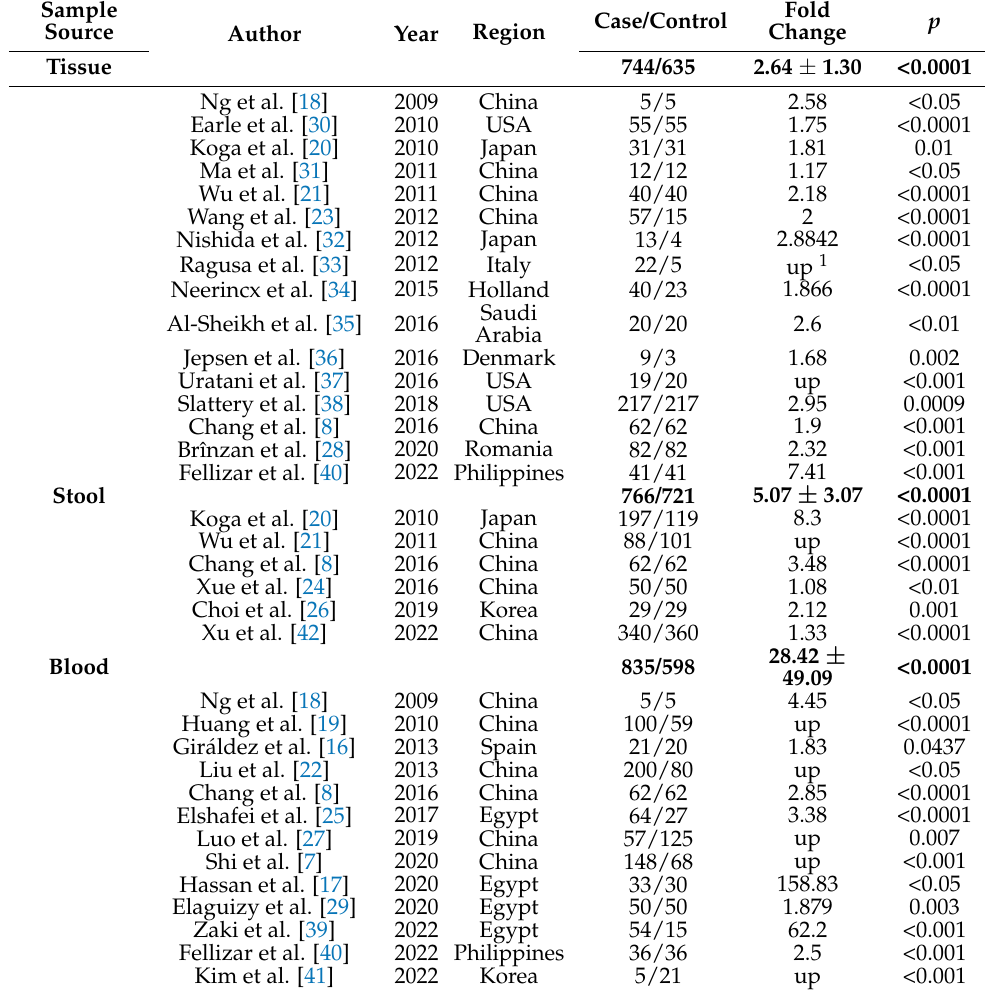
Table 1. MiR-92a expression in colorectal cancer (CRC) versus control.